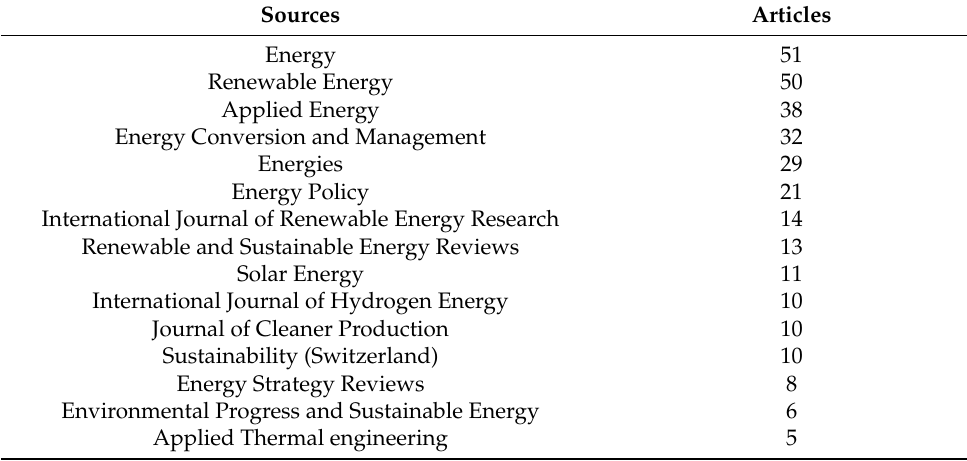
Table 8. Papers by Source (LCOE).